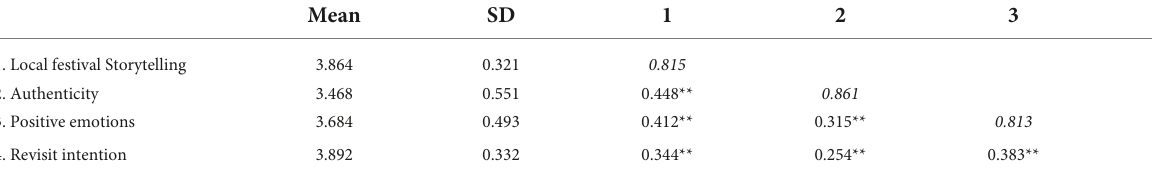
TABLE 1 Construct means, standard deviations, and correlations.